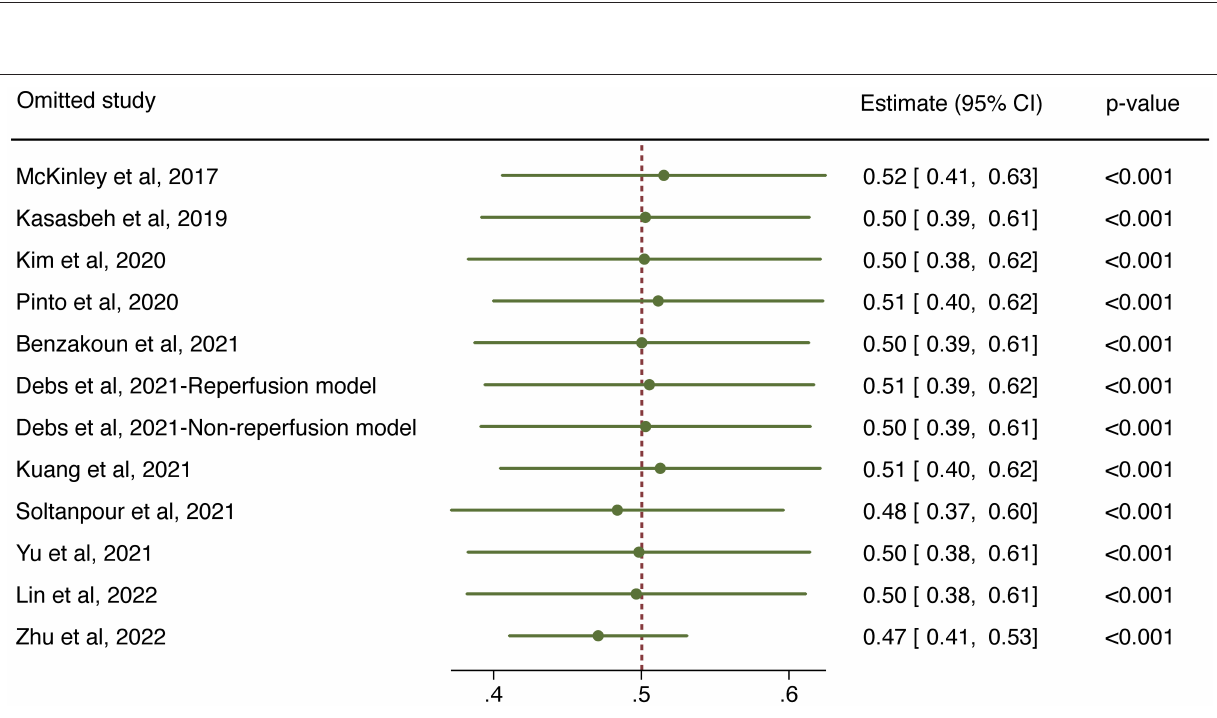
FIGURE 3 | Sensitivity analysis for the overall predictive performance using one-study-removed method.